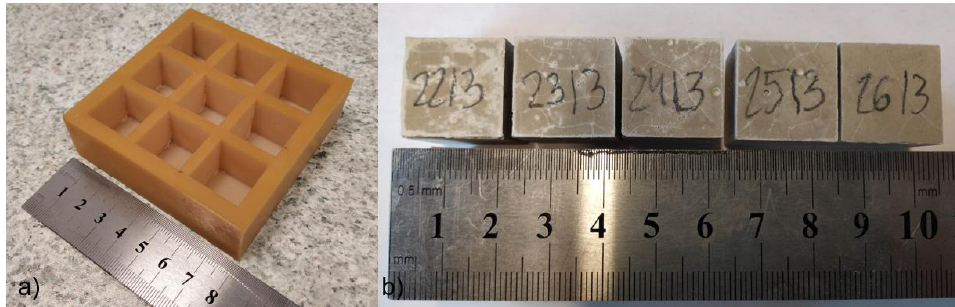
Figure 2. ( a ) Polyurethane mould; ( b ) cracking of the binder specimens after curing in